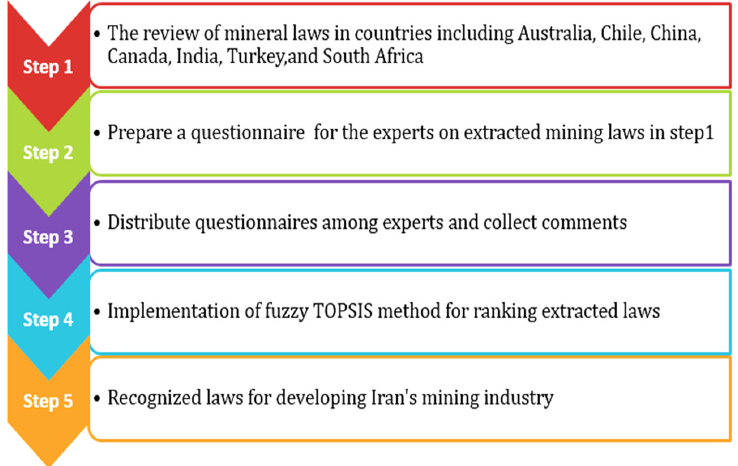
Fig. 1. The research process of this